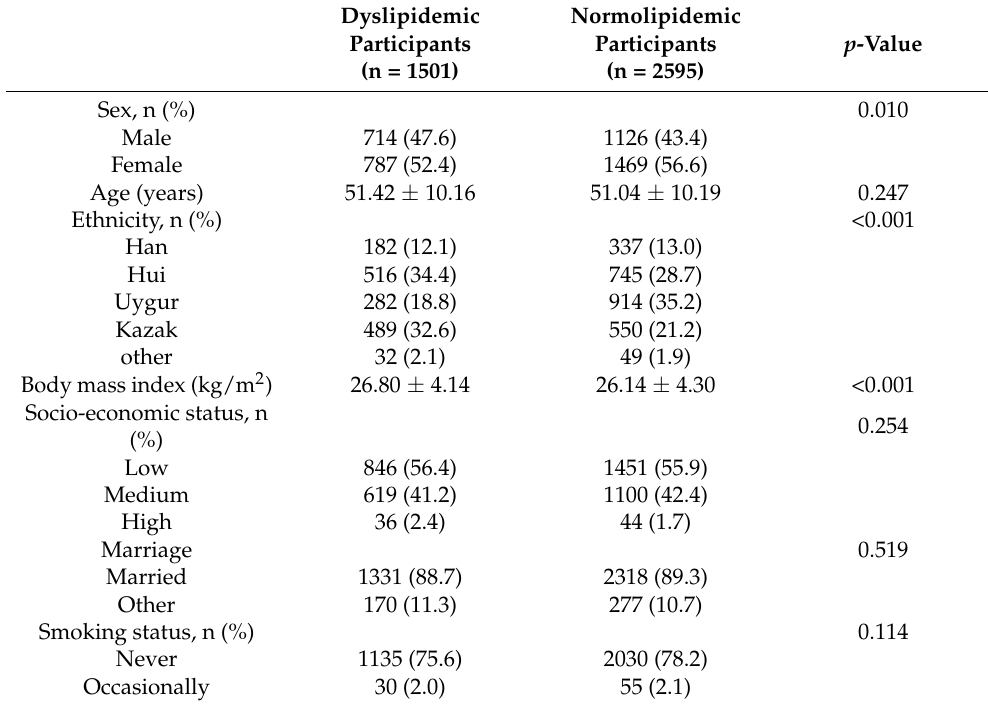
Table 1. Demographic and clinical characteristics of study